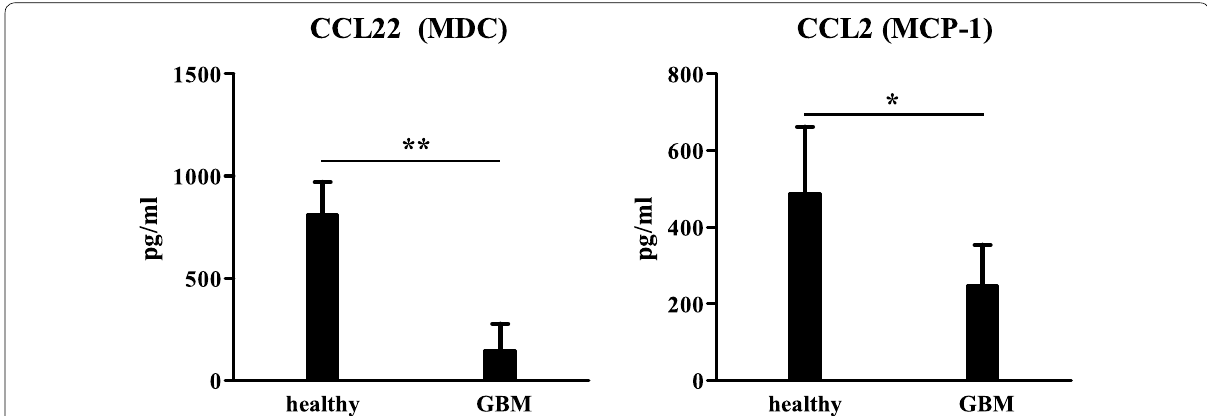
Fig. 6 Serum levels of cytokines in healthy individuals and GBM patients. Serum levels of CCL22 (MDC, left) and CCL2 (MCP‑1, right) from healthy controls (n 7) and GBM patients (n 11) are shown. The cytokine concentrations were measured from serum samples with an multiplex Luminex = = assays in triplicates. *p < 0.05; **p < 0.001. The serum levels of additional cytokines are shown in Additional file 1: Figure